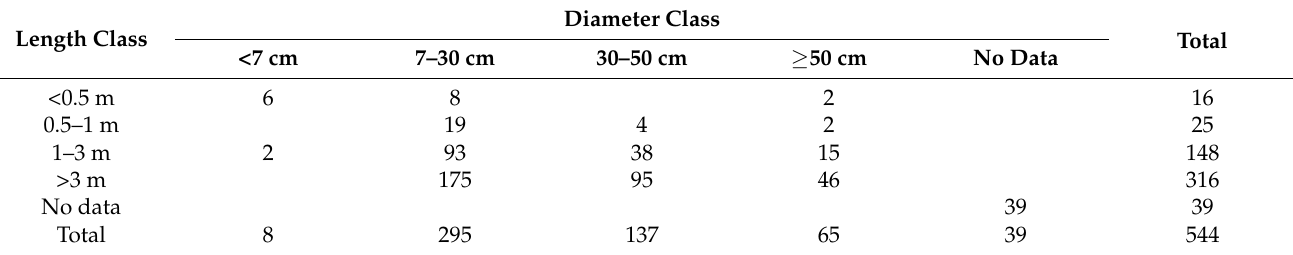
Table 6. Number of logs occupied by Buxbaumia viridis by length and diameter class.